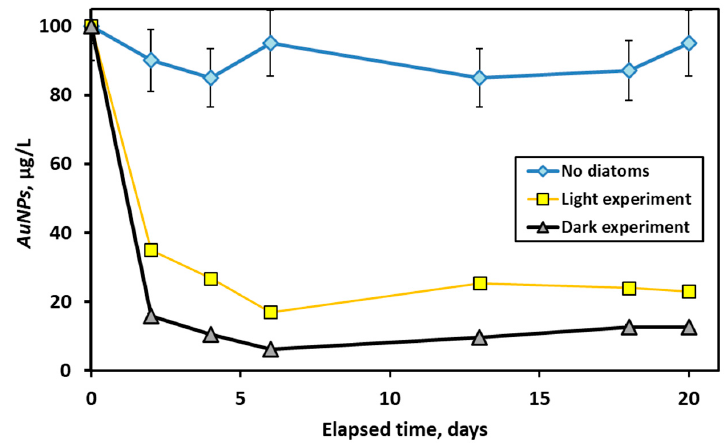
Figure 10. Concentration of AuNPs in 5 mM NaCl + 5 mM NaHCO 3 solution at pH = 8.6 ± 0.1 in the presence of 1 g wet /L live EOMI diatoms under light (yellow squares) and in the darkness (grey triangles). The error bars (s.d. of duplicates) are within the symbol size unless shown.